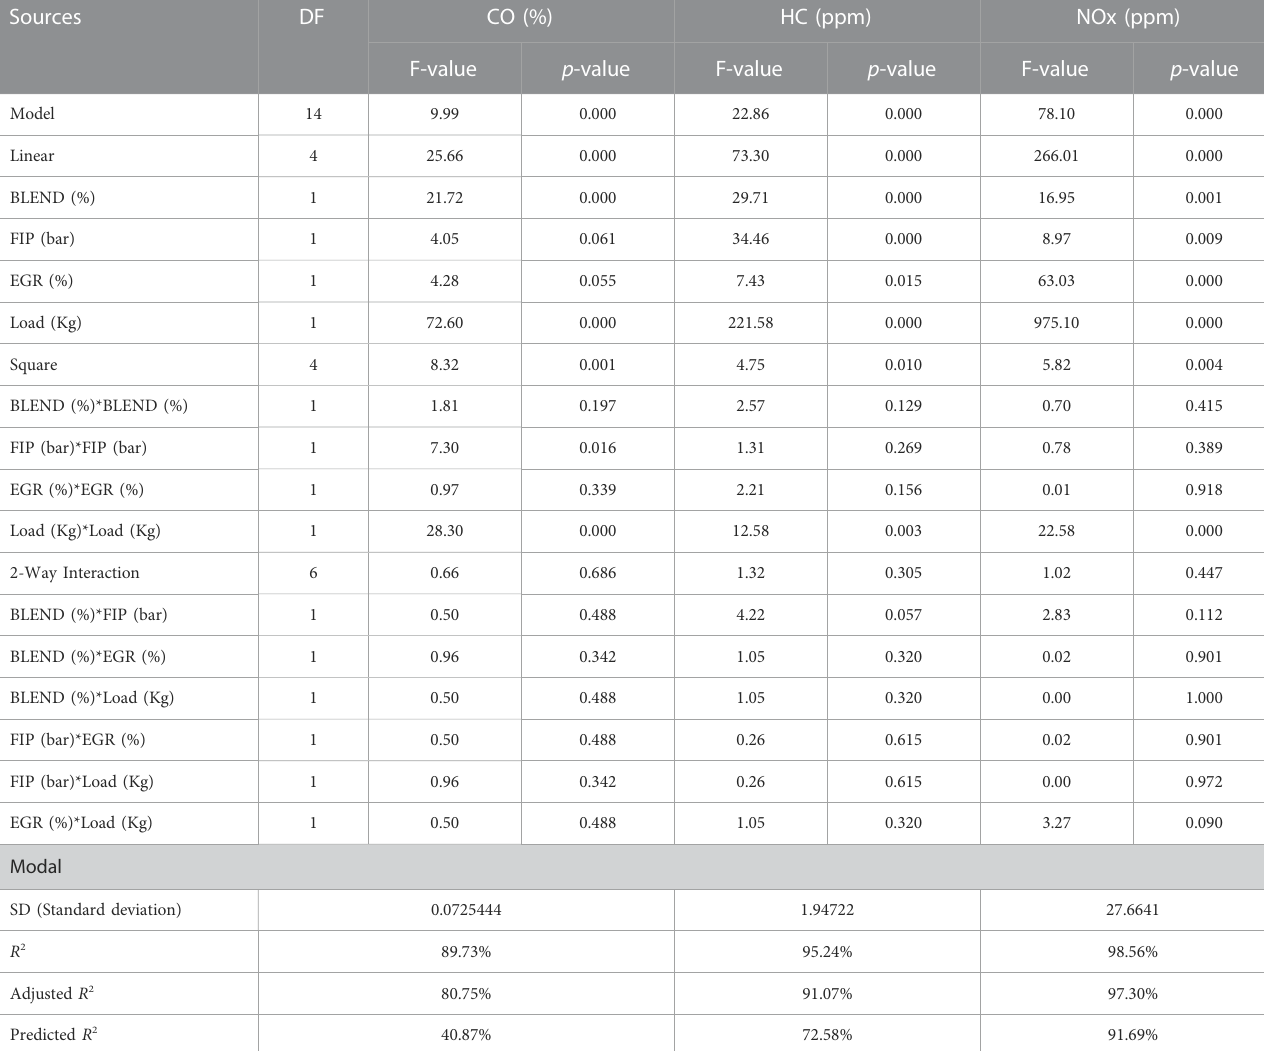
TABLE 8 ANOVA of the developed models for CO, HC, and NOx emission.